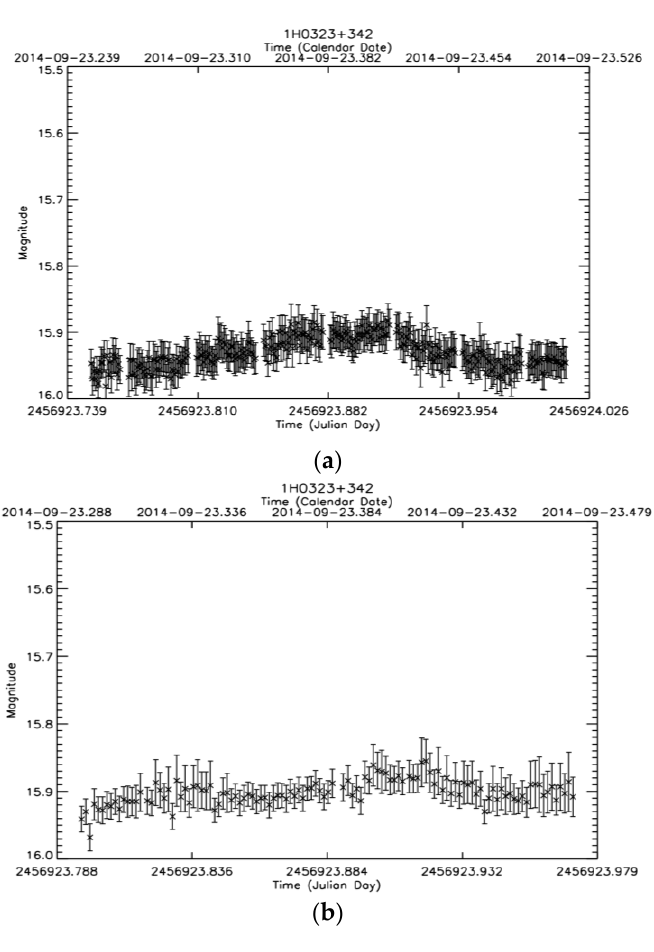
Figure 1. Intra-night R-band light curves of 1H 0323+342. Both light curves are plotted on a 0.5 magnitude scale. Microvariablity is clearly detectable for this object.